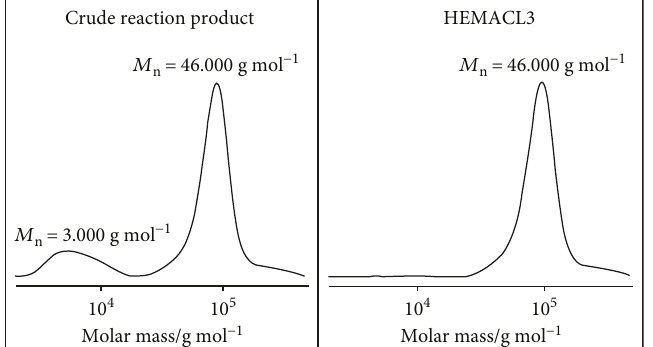
Figure 4: SEC chromatograms from the crude reaction product and the resulting HEMACL3 copolymer after the puri fi cation